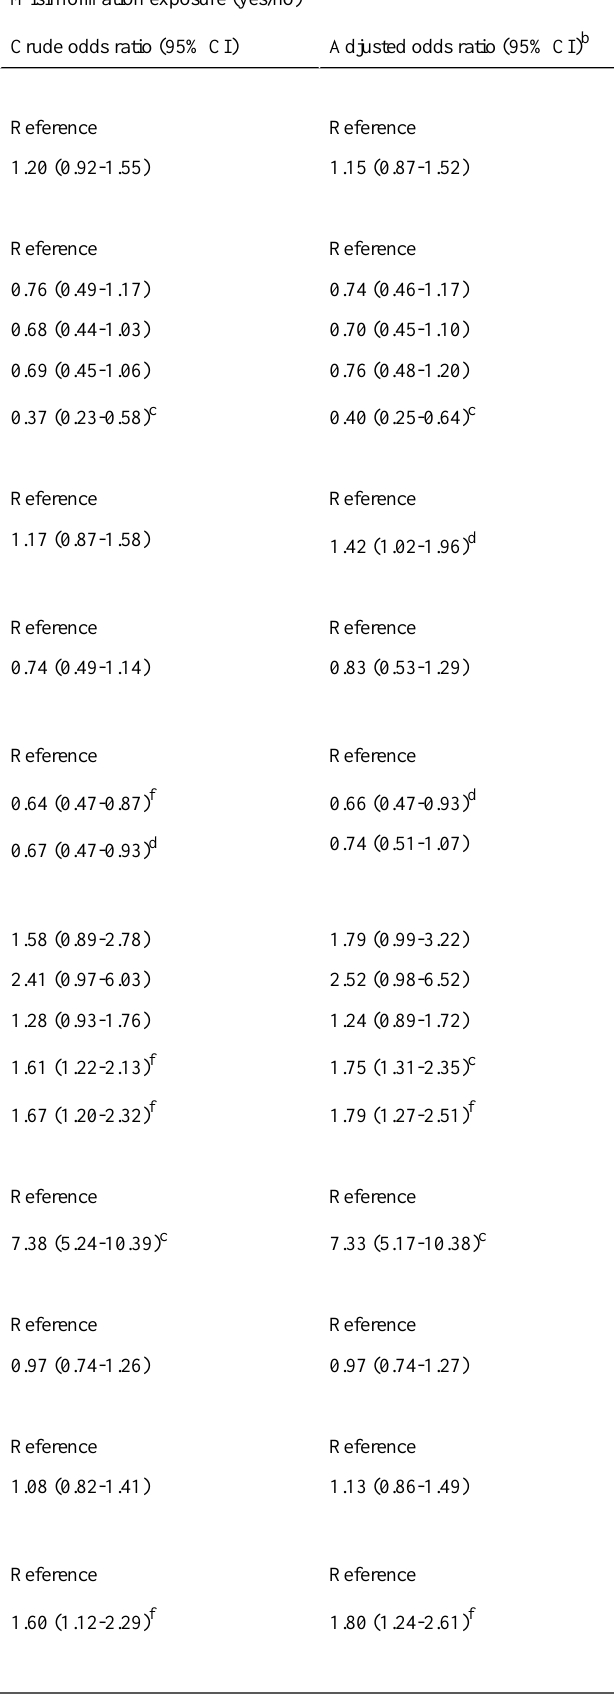
Table 3. Associated factors with COVID-19 misinformation exposure (N=1049) a .